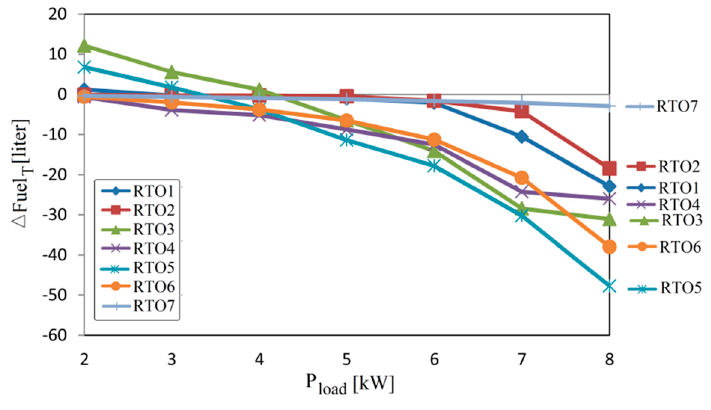
Energies 2019 , 12 , x FOR PEER REVIEW Figure 3. Fuel economy for k fuel = 25 and different P load . Figure 3. Fuel economy for k fuel = 25 and different P load . Figure 3. Fuel economy for k fuel